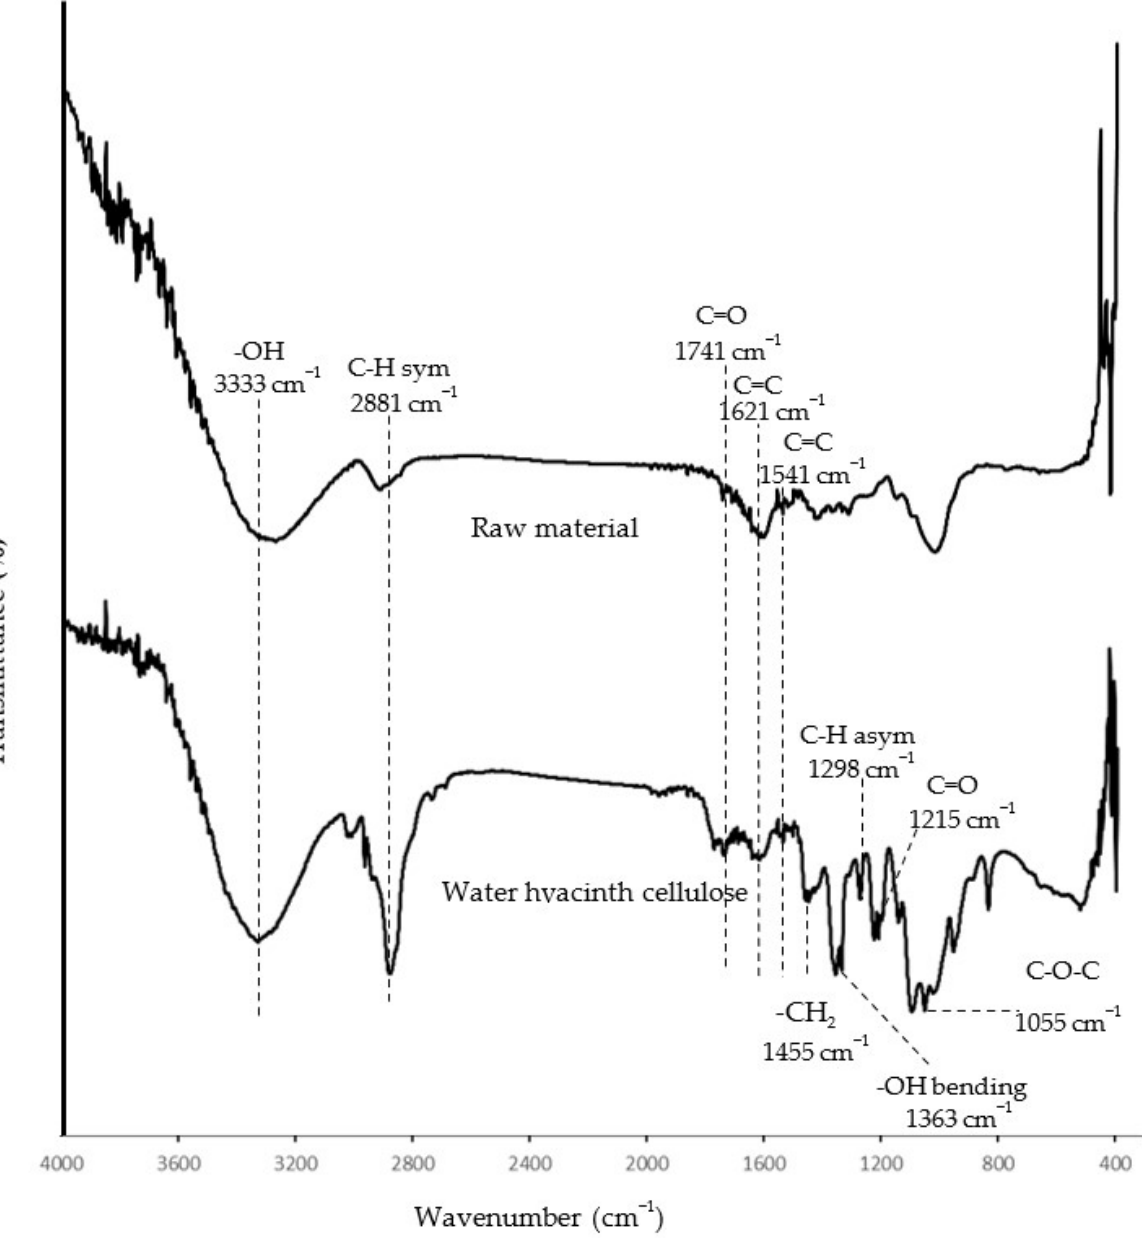
Figure 2. FTIR spectra of water hyacinth cellulose and raw material.